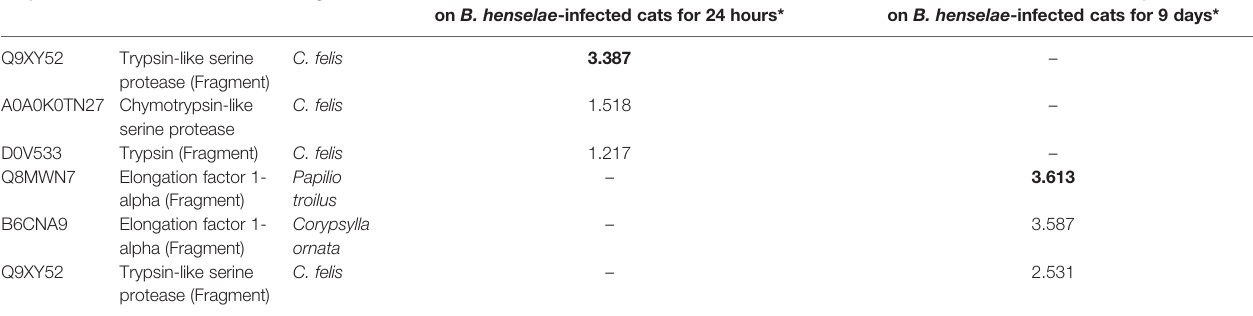
TABLE 5 | Uniprot identi fi cation number, associated protein, and reference organism of FDAP (Flea Differentially Abundant Proteins) in fl eas fed on uninfected cats for 24 hours when compared to fl eas fed on B. henselae -infected cats for 24 hours, and fl eas fed on uninfected cats for 9 days when compared to fl eas fed on B. henselae -infected cats for 9 days.